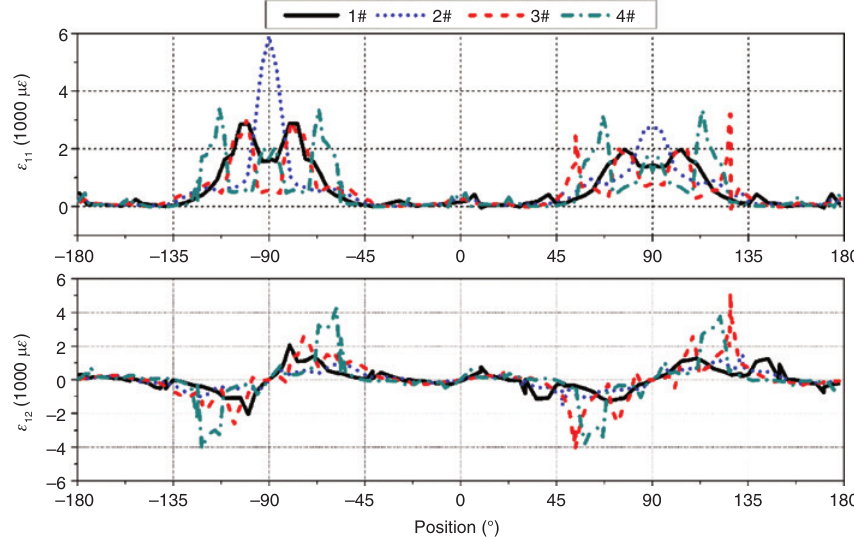
Figure 10: Strain distribution along the edge of the hole obtained from